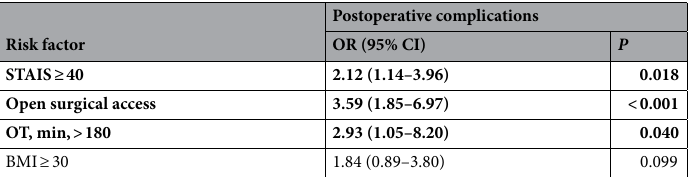
Table 6. Multivariate analysis: Predictors of postoperative complications after adjusting for risk factors (subgroup of patients with complex procedures, N = 221). Adjusted for STAIS, age, BMI, ASA, open surgical access, cancer diagnosis, and longer operative time. OR, odds ratio CI, confidence interval; ASA, the American society of anesthesiologists physical status classification. Significant values are in